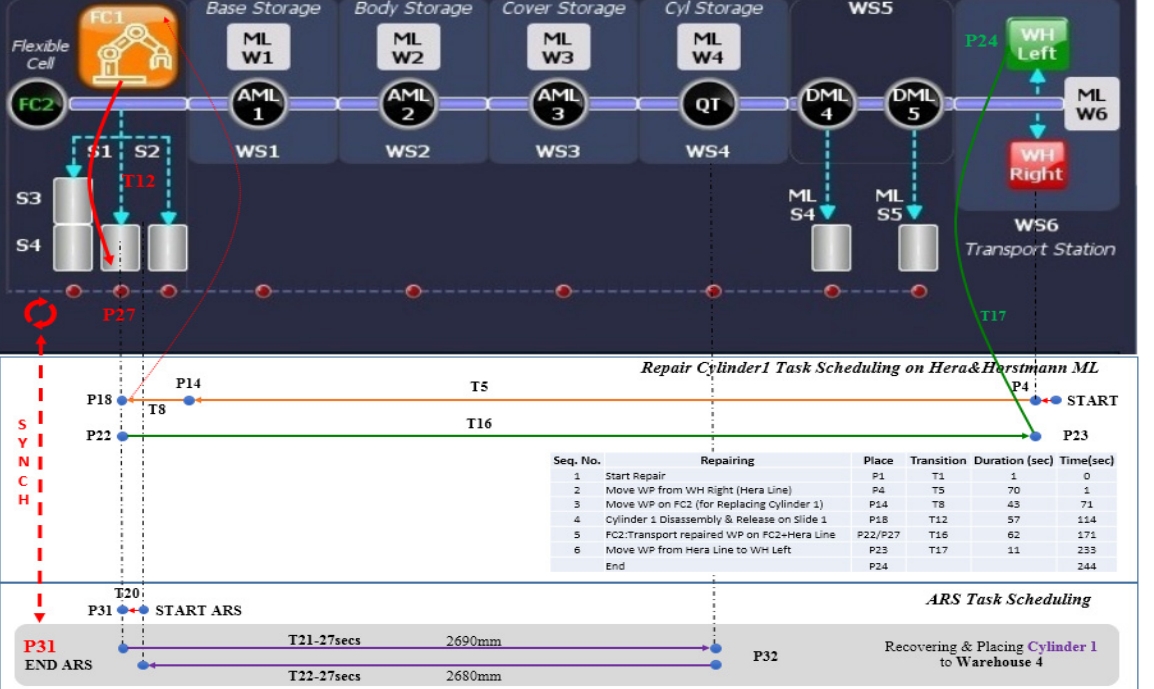
Figure 17. ARS task scheduling for repair/replace Cylinder 1.